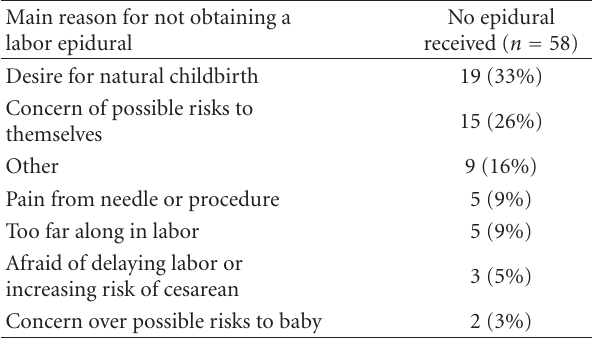
Table 6: Responses to the question. “After coming to the hospital, what was your main reason for not obtaining an epidural for